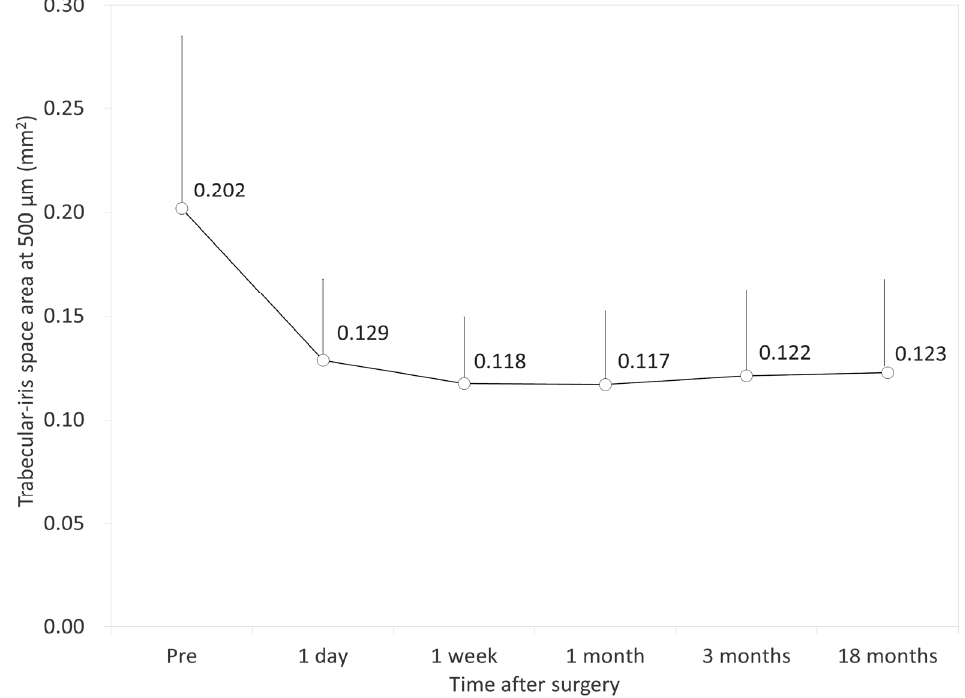
Figure 3. Time course of trabecular-iris space area at 500 µm (TISA500) after implantable collamer lens (ICL) implantation. The TISA500 was significantly decreased 1 day postoperatively and subsequently stabilized over time. Bar represents standard deviation.